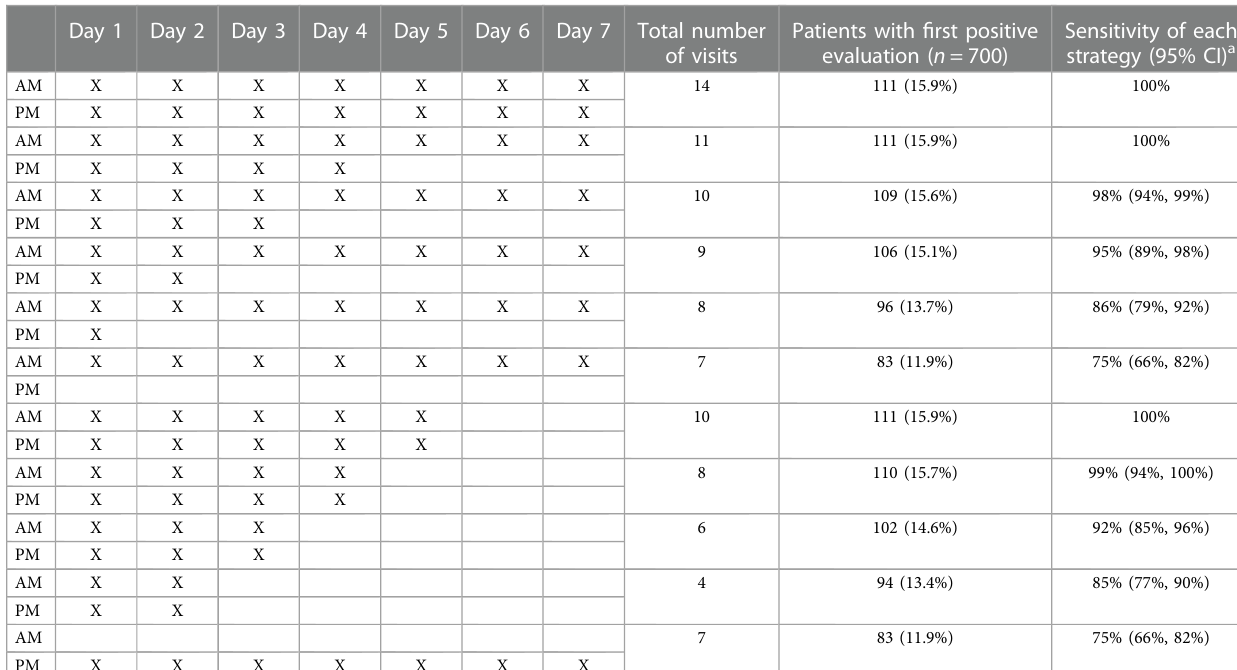
TABLE 3 Various evaluation strategies for detecting postoperative